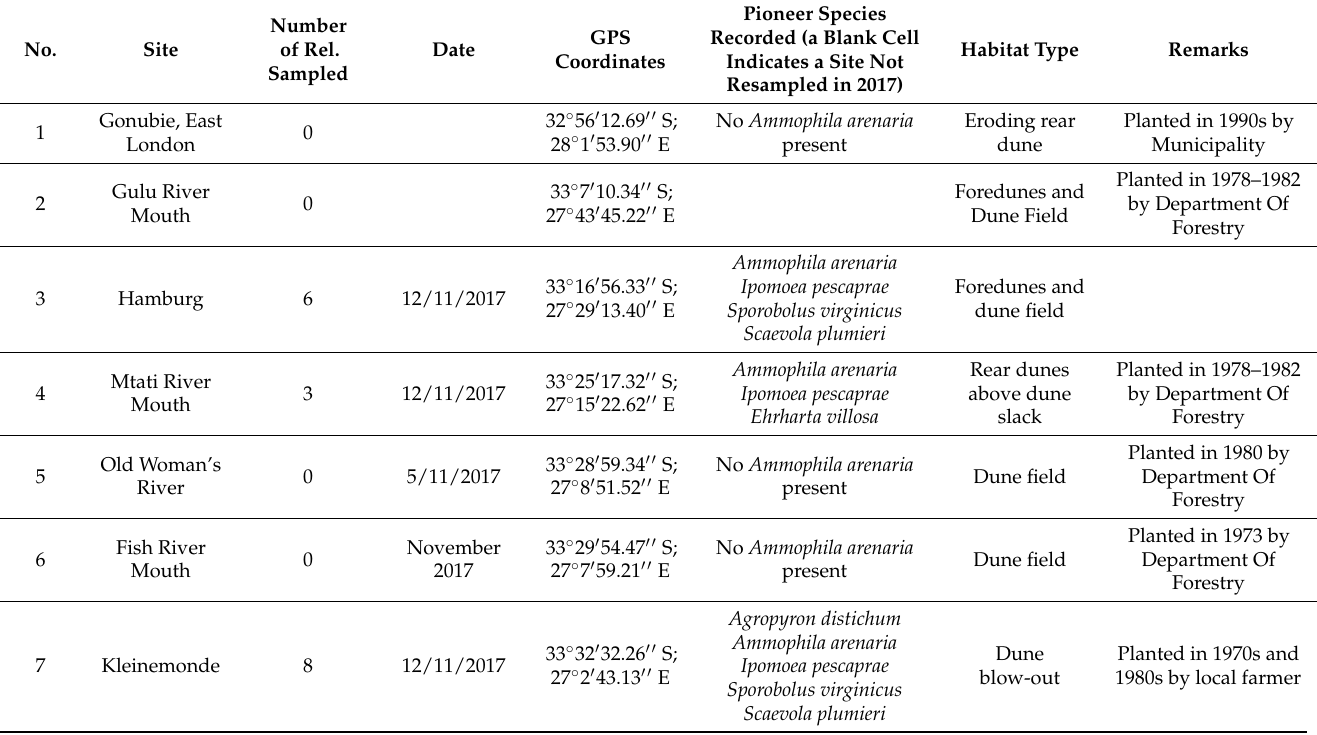
Table 3. Sample sites of marram grass in the Eastern Cape and some results recorded in